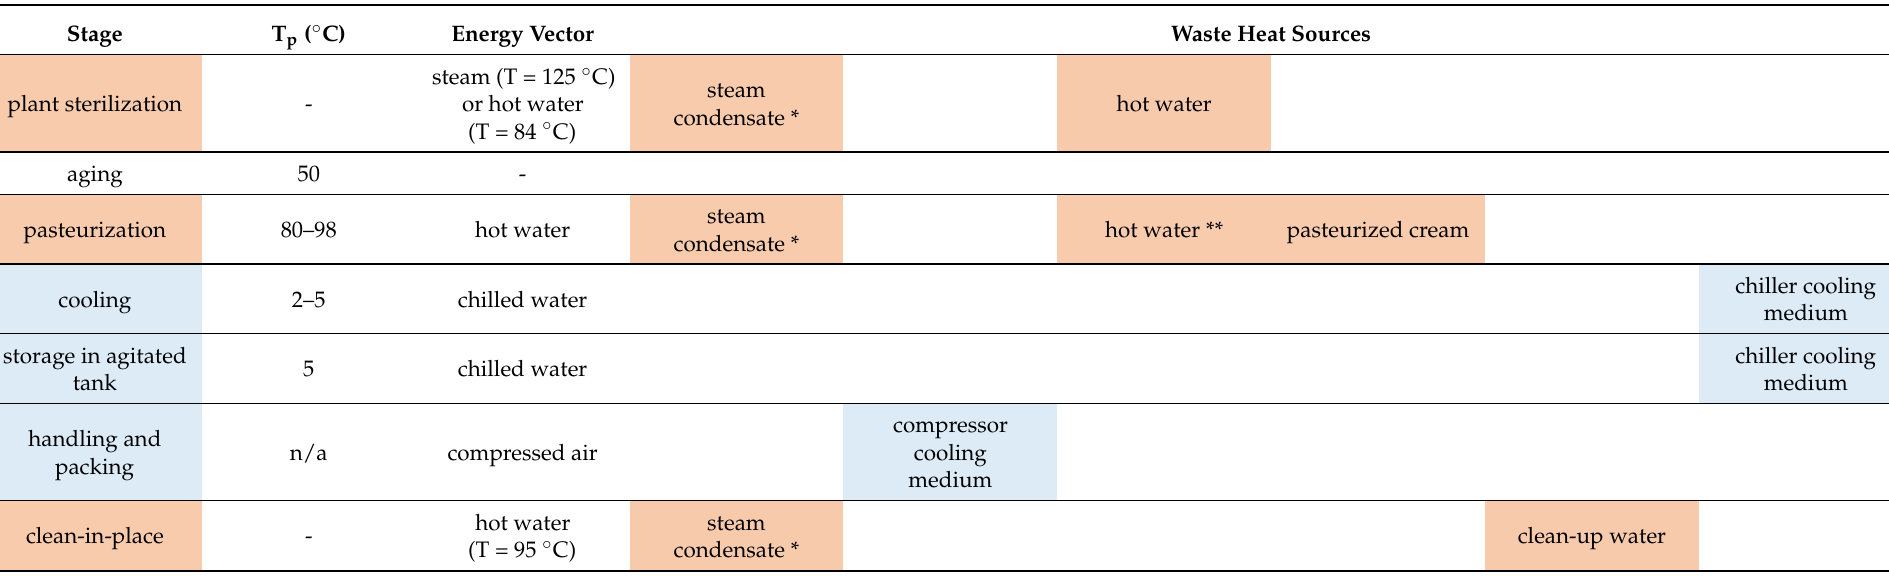
Table A3. Scheme of pasteurized cream manufacturing process and corresponding low-temperature waste heat